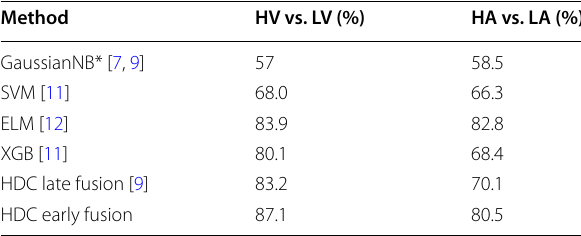
Table 1 AMIGOS classification accuracy comparison table